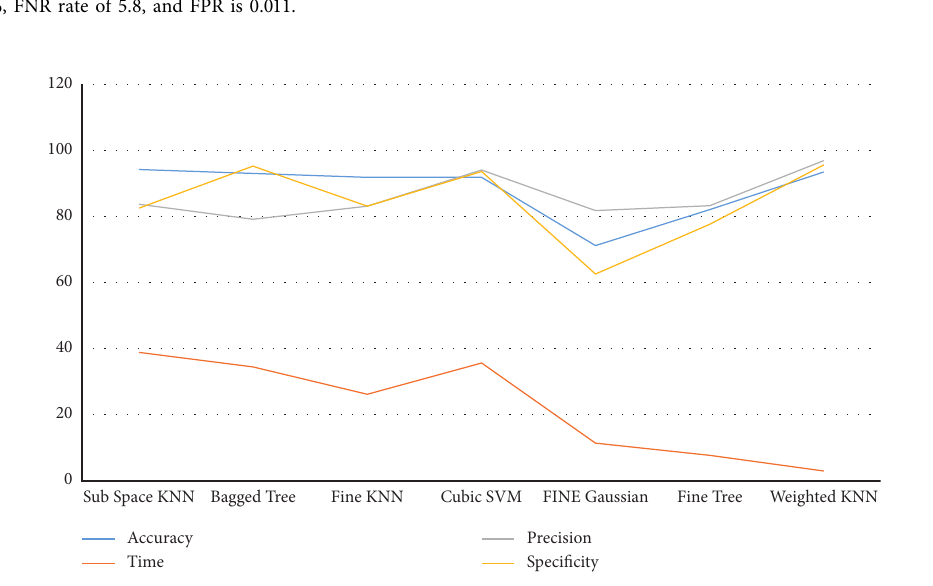
Figure 11: Graphical representation of classification methods in terms of accuracy, time, precision, and specificity for experiment